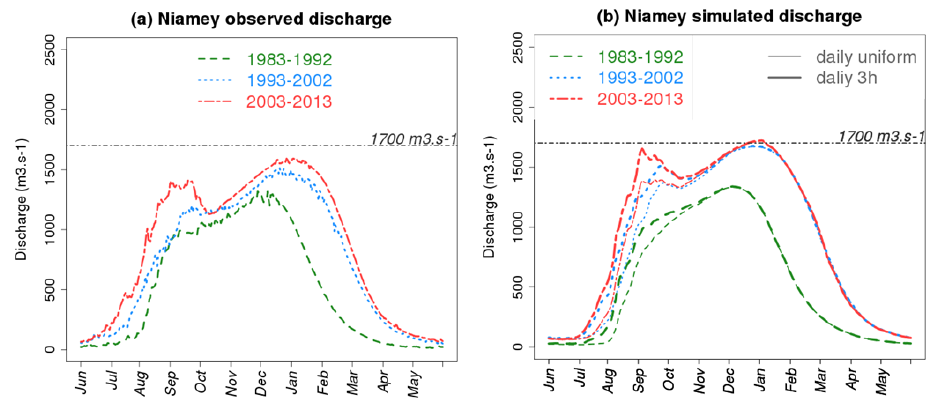
Figure 3. Mean observed (a) and simulated (b) discharge at Niamey station for 3 decades: 1983–1992 (green dashed line), 1993–2002 (blue dotted line) and 2003–2013 (red mix dashed